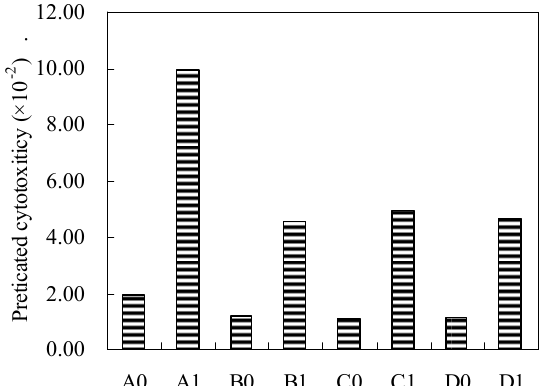
Figure 5. Estimated cytotoxicity of the sum of the measured HAN and TCNM during pre-oxidation subsequent chlorination of Asp (The meaning of the number is the same as above, Asp = 0.1 mM, oxidant (OZ, PM, and Fe(VI)) = 5 mg / L, Br _ = 1 mg / L, pre-oxidant contact time = 0.5 h, chlorine contact time = 24 h, pH = 7 ± 0.2, and temperature = 22 ± 1 ◦ C). The bars represent the standard deviation of replicate measurements ( n = 3).